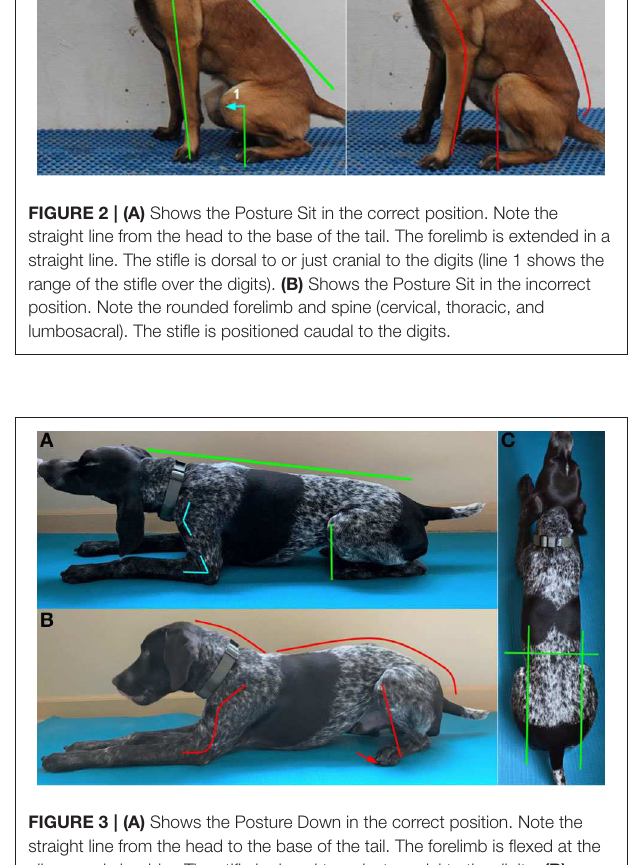
( Figure 2A ). During the movement, the dog’s stifles should move dorsal to or just cranial to the hindlimb digits. To perform the Posture Down, the dog should lay down so that the ipsilateral right and left limbs are within the same sagittal plane, often referred to as a “sphinx” position ( Figure 3 ). To achieve the Posture Down position, the dog flexes its shoulder and elbow 10–20 ◦ depending on size of the dog, rolls its pelvis forward, and extends its spine to form a straight line from the nose to the base of the tail ( Figure 3A ). During the movement, the dog’s stifles should move dorsal to or just cranial to the hindlimb